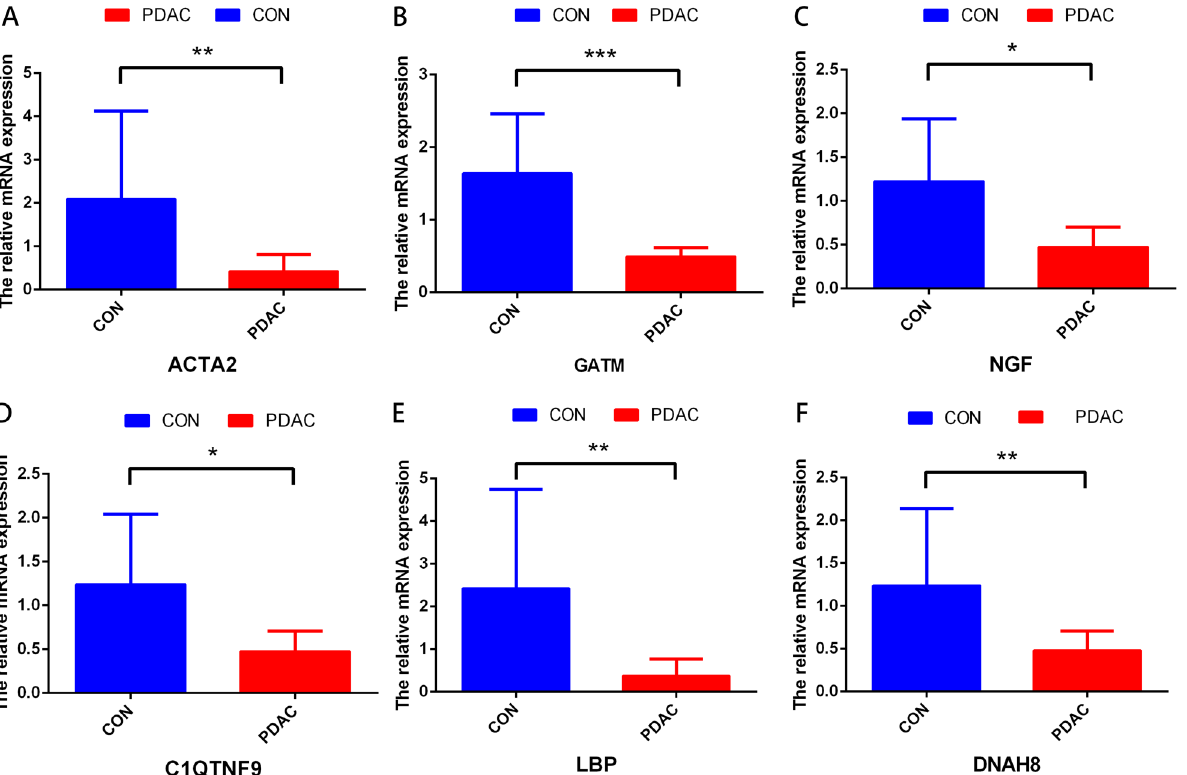
Figure 7. The expressions of six signature genes were validated by quantitative real-time PCR (qRT-PCR). ( A – E ) Expression of genes at the mRNA level by qRT-PCR. qRT-PCR, quantitative real-time PCR. * P < 0.05; ** P < 0.01; *** P < 0.001. ns, no